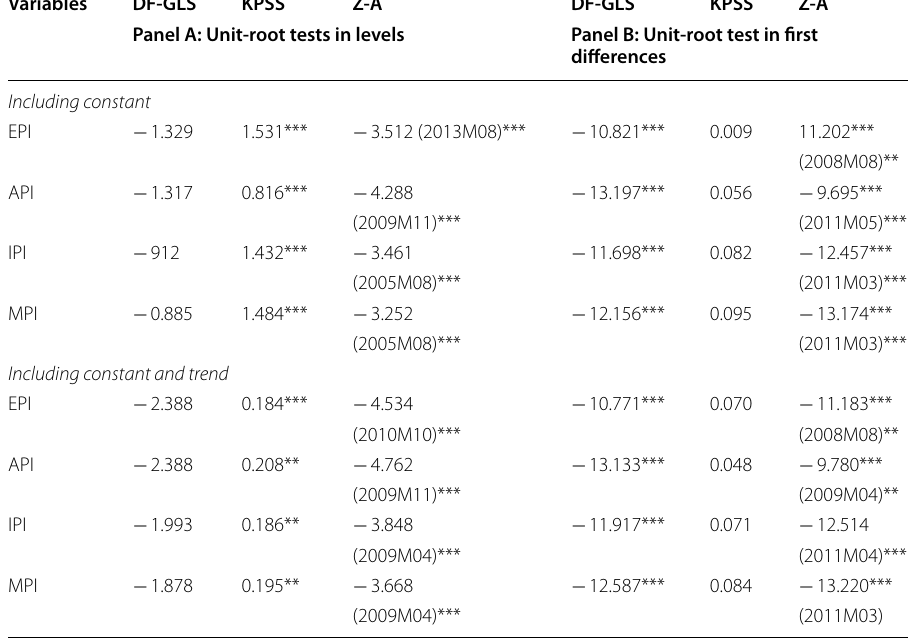
Table 2 Unit root